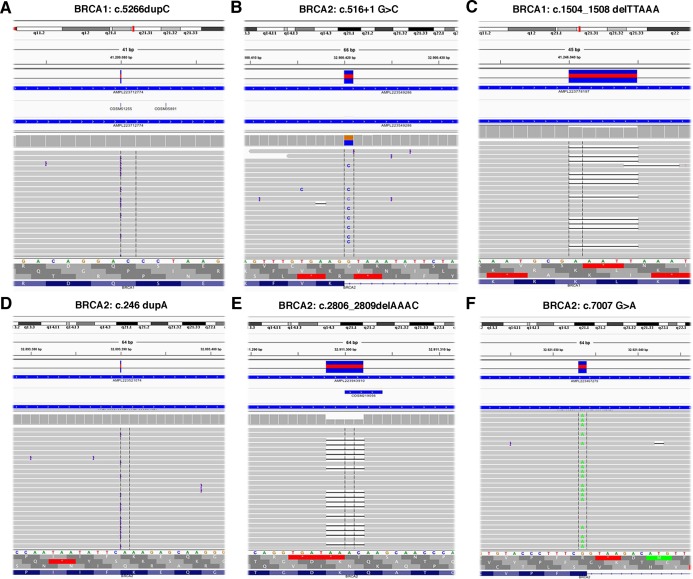
Representative image of read alignments visualized with IGV showing the germline mutations detected by NGS default analysis (A–F).